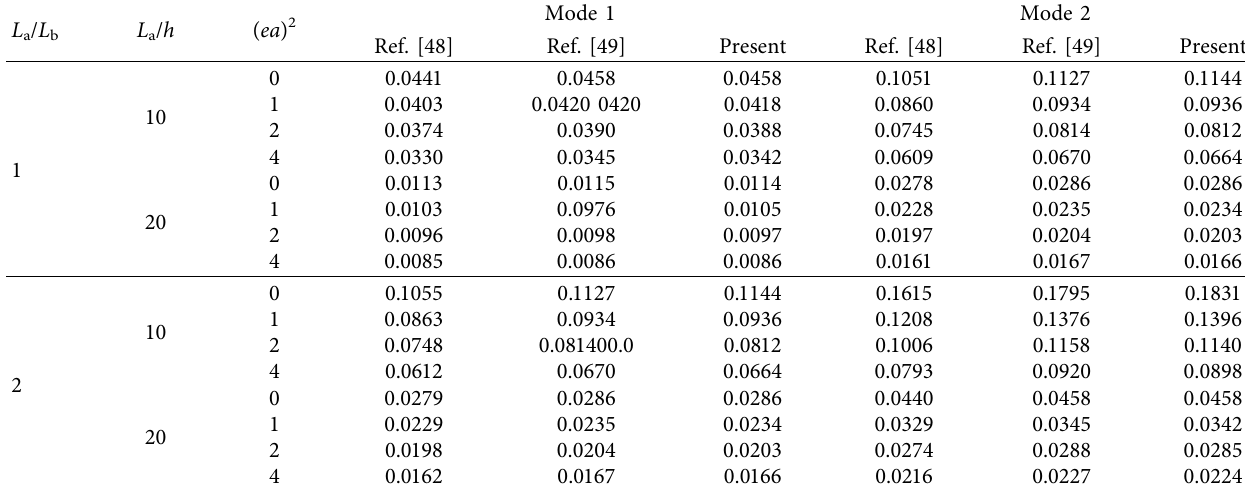
Table 1: Comparison of nondimensional fundamental natural frequencies of FG nanoplates.